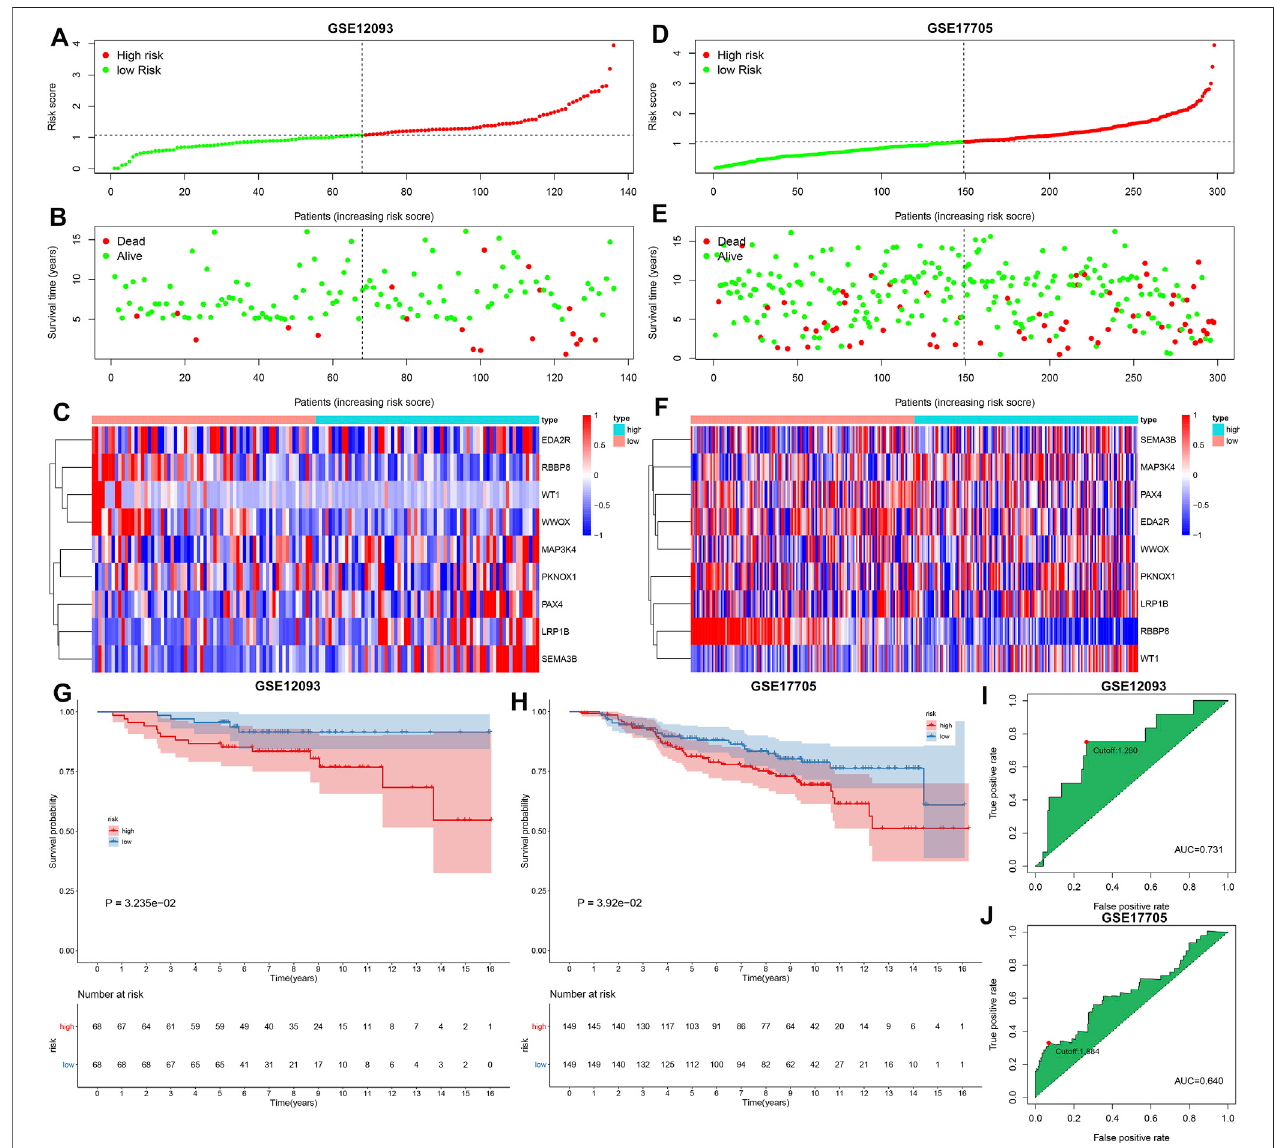
FIGURE3| Externalveri fi cation ofthe predictive performanceoftheTSG-basedprognostic classi fi er inbreast cancerprognosisinthe GSE12093 and GSE17705 datasets. (A – C) Distribution of RS, survival status, and mRNA expression of characteristic TSGs in high- and low-risk subgroups in the GSE12093 dataset. (D – F) Distribution of RS, survival status, and mRNA expression of characteristic TSGs in high- and low-risk subgroups in the GSE17705 dataset. Vertical dotted line represented the cutoff value of high- and low-risk subgroups. (G,H) Kaplan – Meier curves of OS and log-rank tests of high- and low-risk subgroups in the GSE12093 and GSE17705 datasets. (I,J) ROC curves of the TSG-based prognostic classi fi er in the GSE12093 and GSE17705